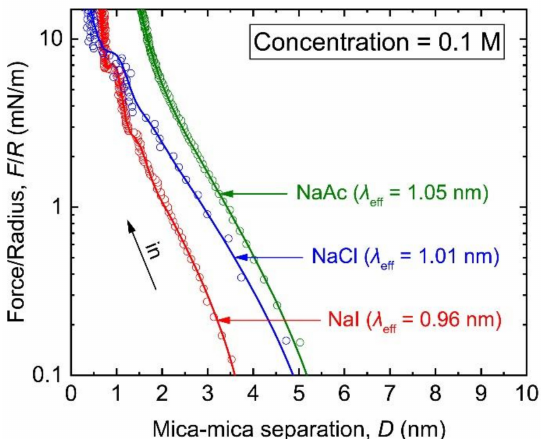
Figure 2. Semi-log plot of F / R versus D ( F / R vs. D profiles) between two mica surfaces in the electrolyte solutions at a concentration of 0.1 M. The solutes include NaI (red), NaCl (blue), and NaAc (green). The decay length (obtained by the fitting of the curves) for each solution is noted in the corresponding bracket. The label “in” denotes the surface